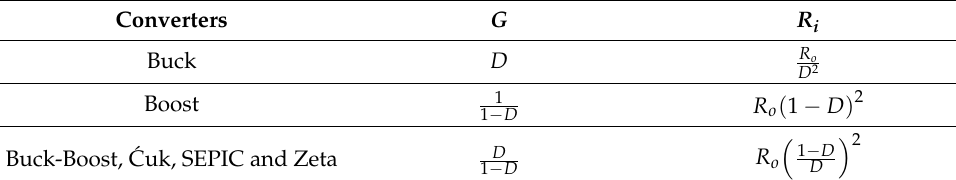
Figure 6. Flowchart of the proposed tracking algorithm.